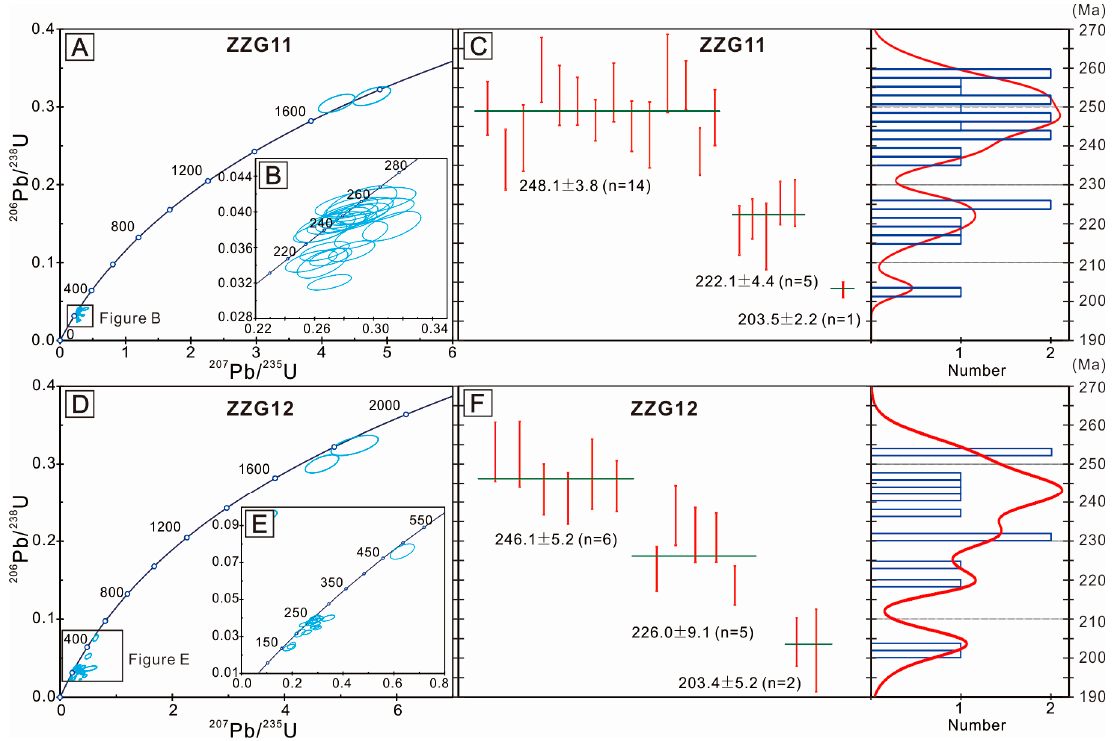
Figure 7. LA-ICP-MS zircon U-Pb concordia diagrams for ZZG11 ( A – C ) and ZZG12 ( D – F ).